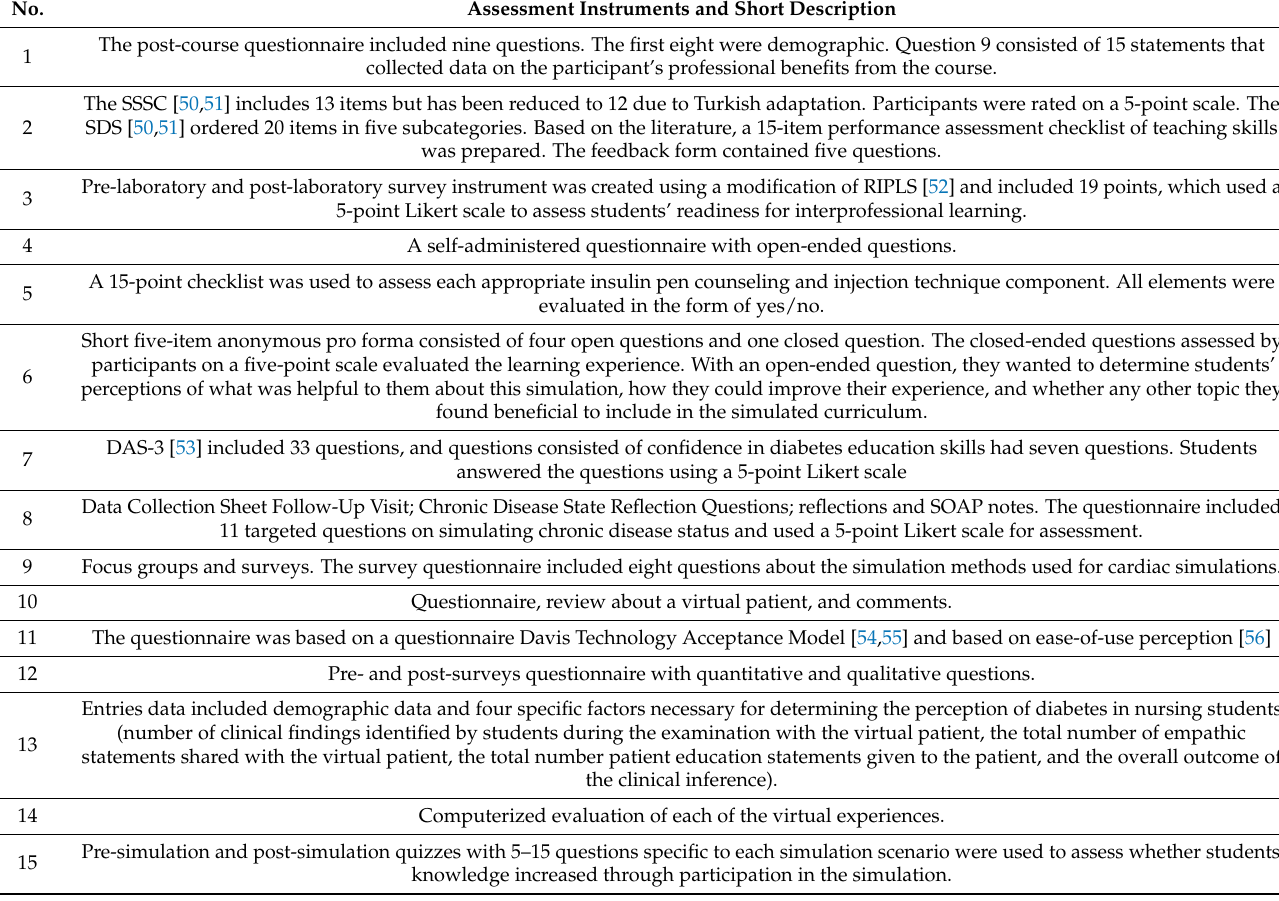
Table 3. Instruments used for evaluating the outcomes of the